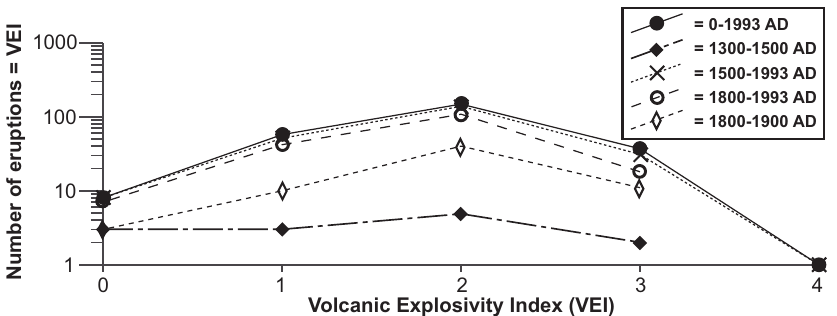
Fig. 2. Relationship between the number of eruptions and the «magnitude» of the eruption expressed by the volcanic explosivity index (VEI) for Etna, Stromboli, and Vulcano. Data (tables III and IV) are from Simkin and Siebert